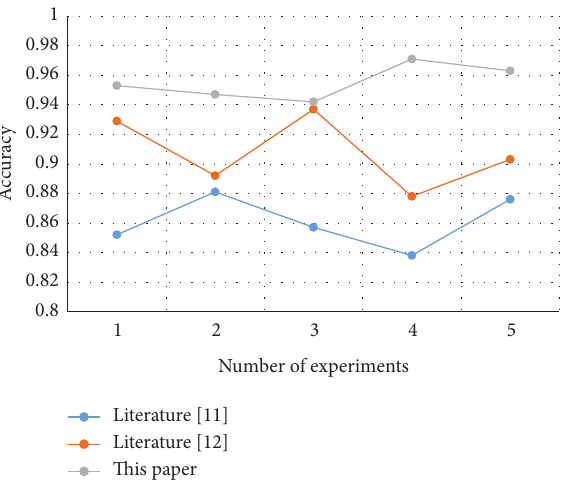
Figure 4: Accuracy of noise-removed music signals.